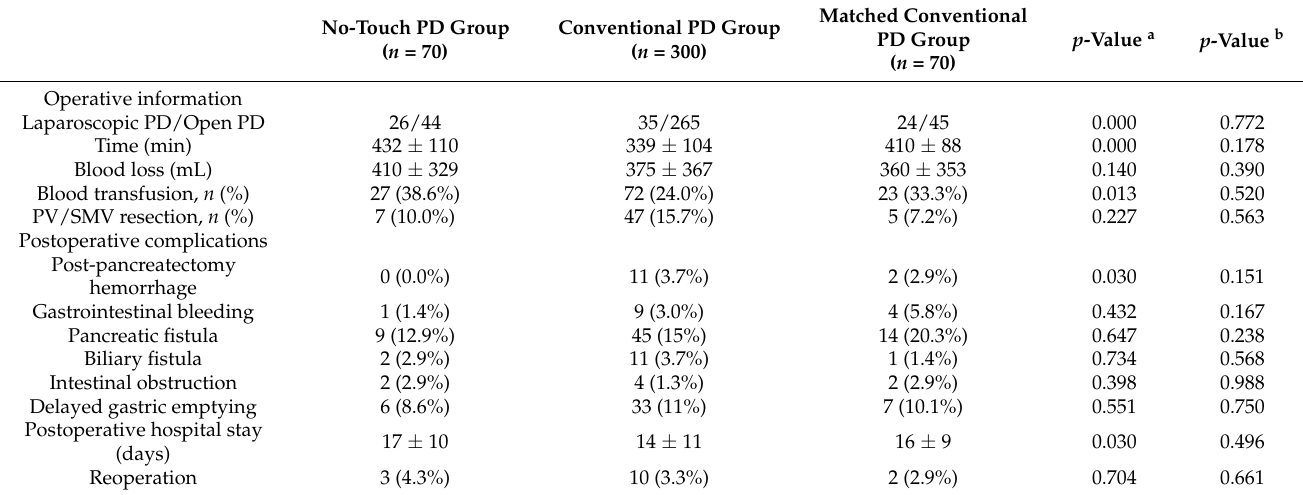
Table 2. Operative results.